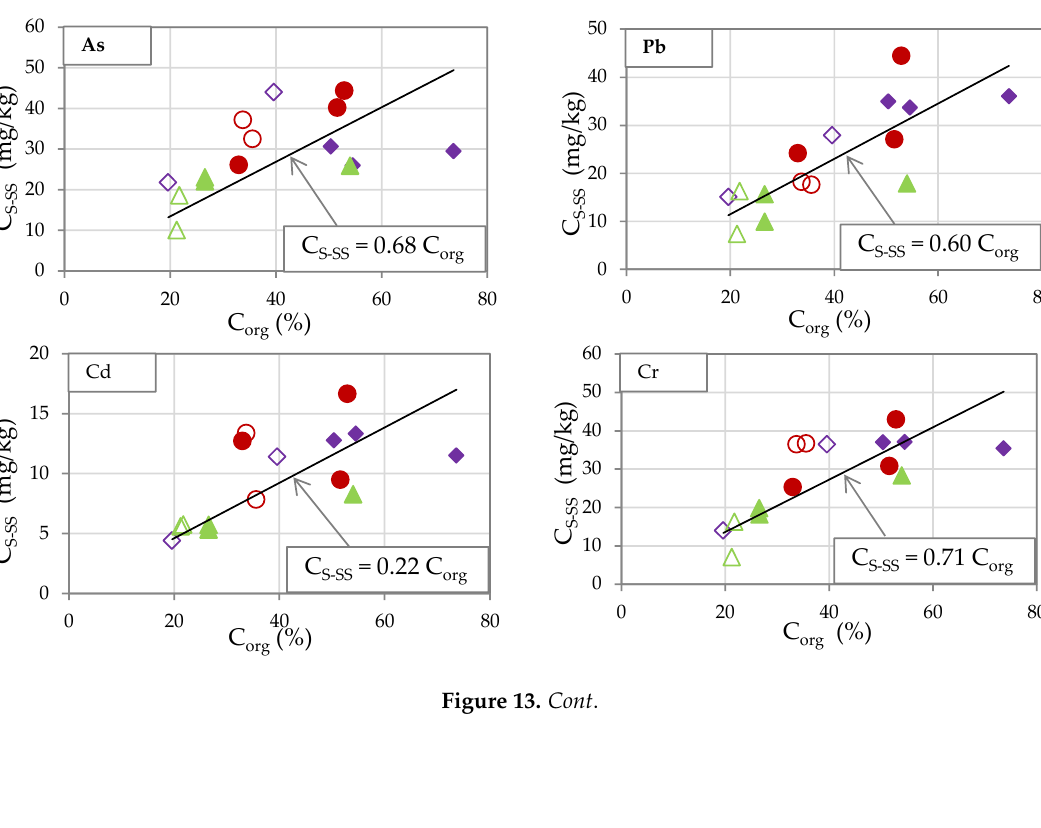
Figure 12. Relationship of the heavy metal content of suspended solids (C S-SS ) and the liquid part of the leachate (C L-LC ).